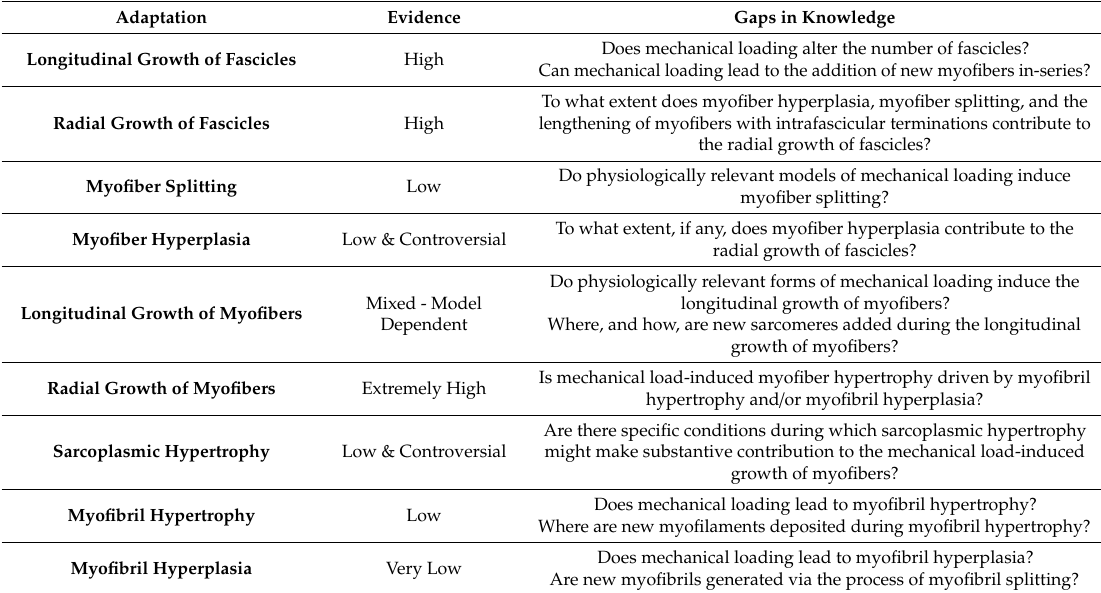
Table 1. The Structural Adaptations that Drive the Mechanical Load-Induced Growth of Skeletal